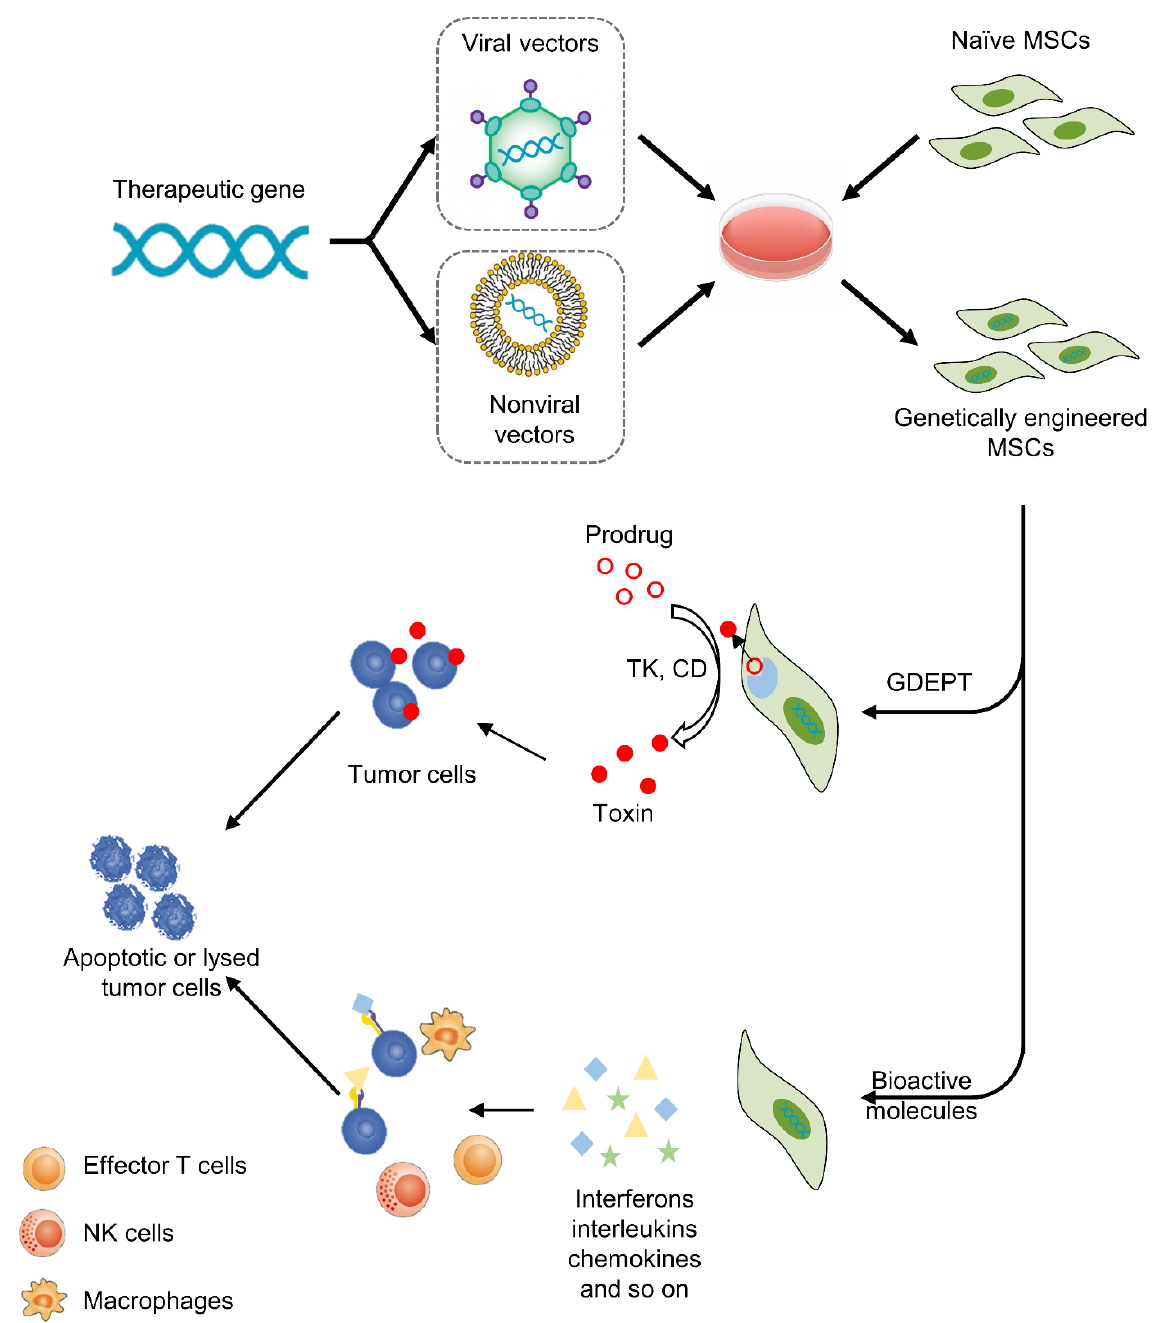
Figure 2. MSC-based cancer gene therapy. Therapeutic genes are transferred into MSCs by viral or nonviral vectors in vitro, then MSCs deliver therapeutics to tumors. There are two basic strategies, including GDEPT and therapy with bioactive molecules. For GDEPT, MSCs can produce enzymes that can convert prodrugs into activated cytotoxic drugs and induce apoptosis and necrosis of cancer cells. As another strategy, MSCs can secret bioactive molecules, which not only exert direct antitumor effects but also activate immune cells and enhance the anticancer immune response.